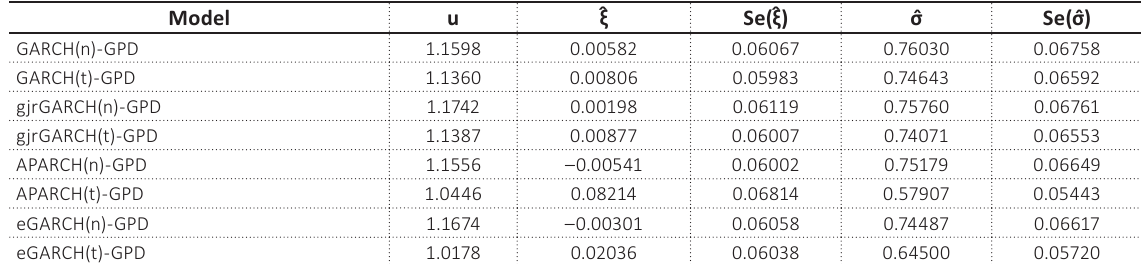
Table 3. Maximum likelihood estimates (MLE) of GARCH (1,1) residuals from BTC/USD to the Generalized Pareto